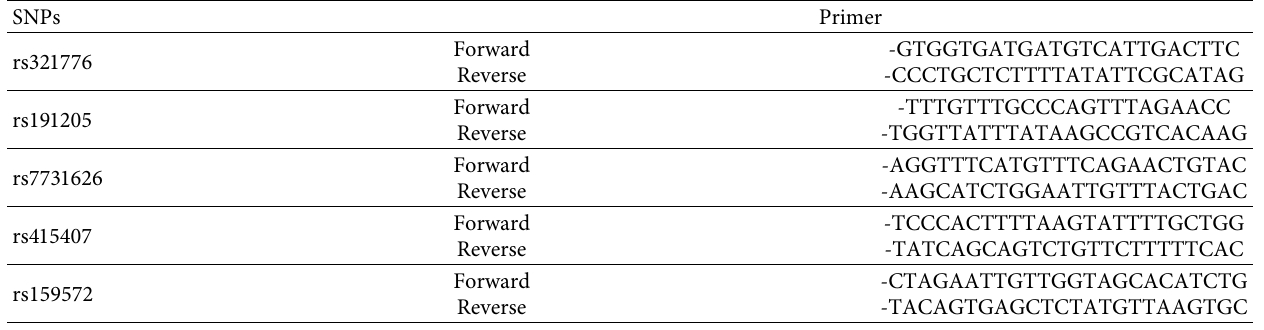
Table 1: Sequence of primers used for five SNPs in ANKRD55 gene.